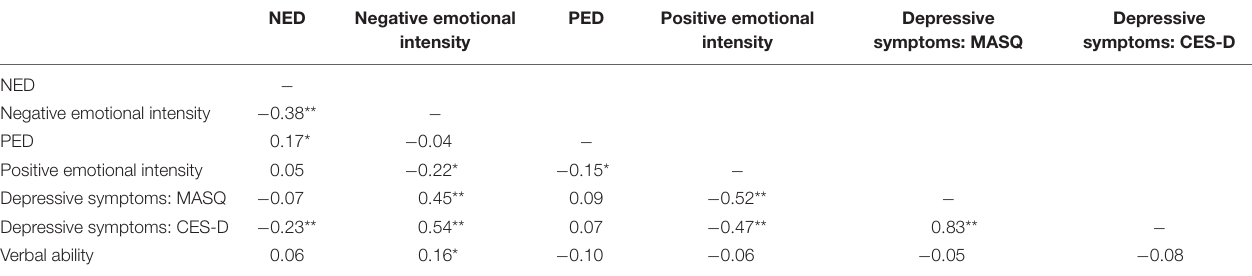
TABLE 1 | Spearman’s correlations between emotion differentiation, emotional intensity, depressive symptoms, and verbal ability. NED